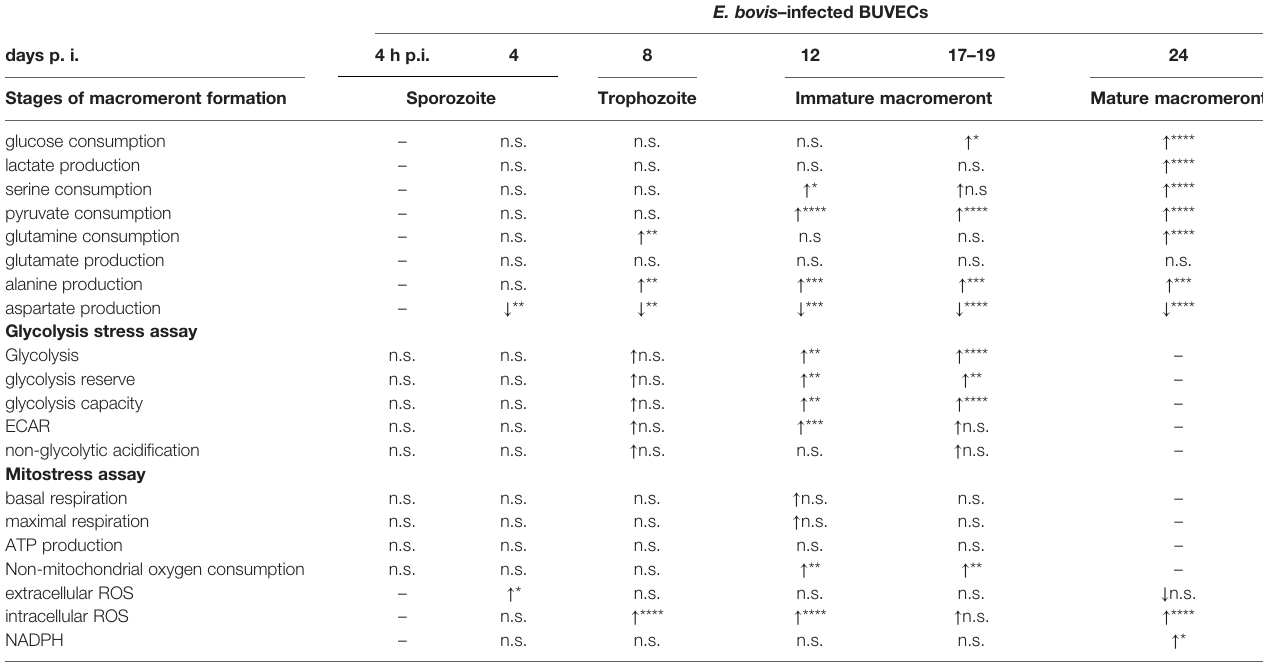
TABLE 1 | Summary of the metabolic measurements on E. bovis – infected